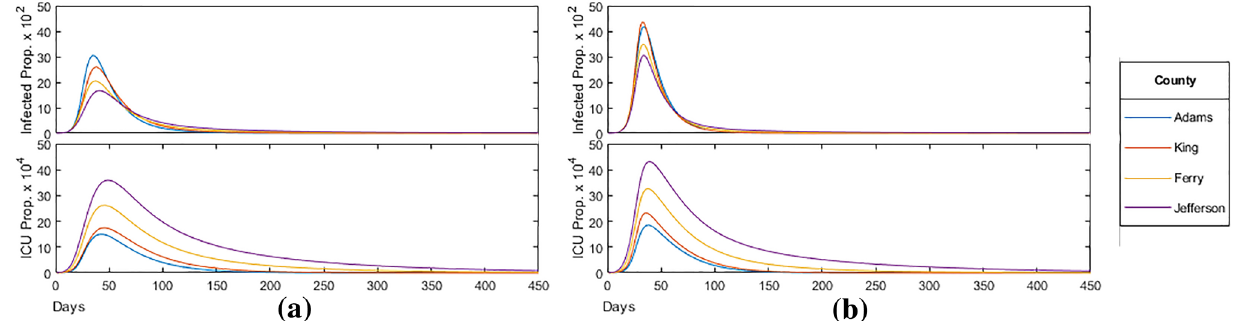
Figure 13. ( a ) School bracket relaxed ( < 30 years); ( b ) work bracket relaxed ( < 60 years).